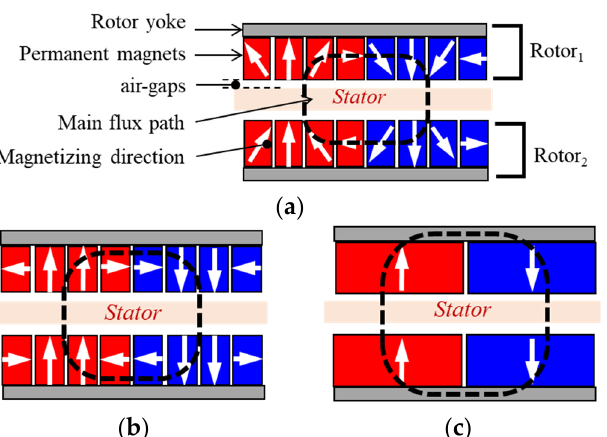
Figure 3. Three rotor models according to the arrangement of the magnetization direction: ( a ) Type-I; ( b ) Type-II; and ( c ) normal array (NA).